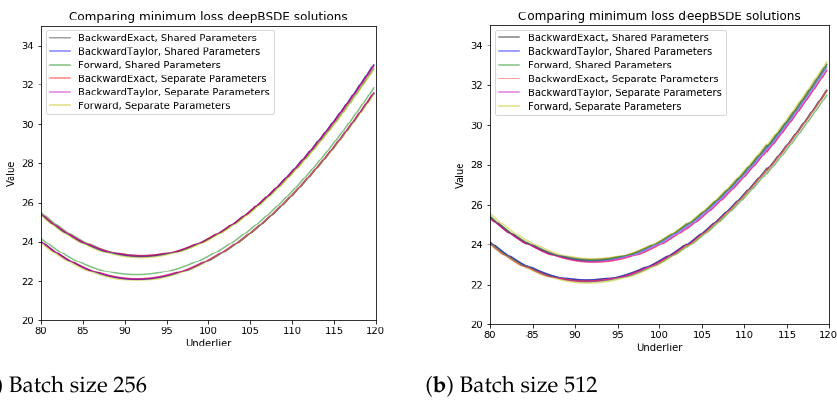
Figure 11. Yinit ( X 0 ) for various methods for two batch